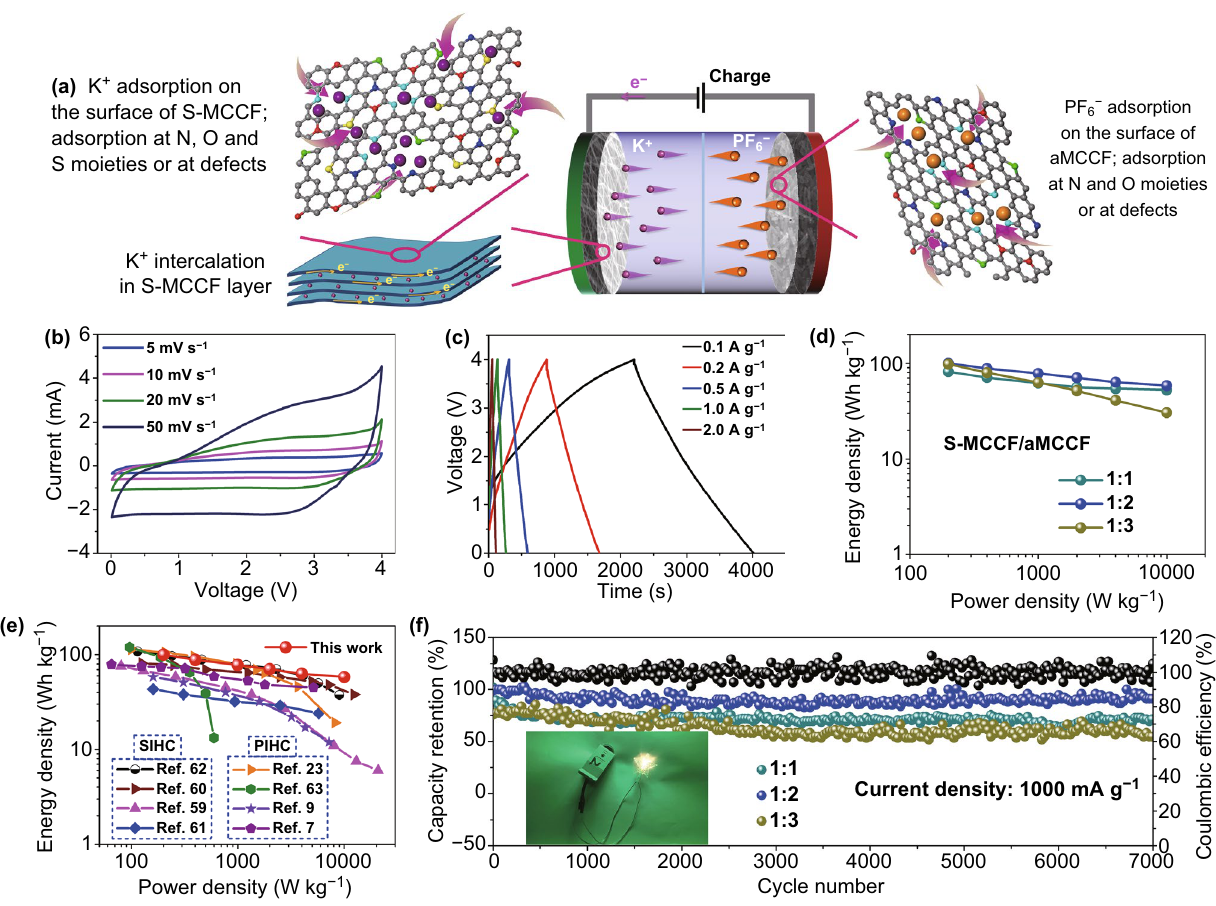
Fig. 5 a Schematic illustration of the charge process for the S-MCCF//aMCCF PIHC. Performance of the PIHC ( m anode : m cathode = 1:2): b CV curves at different scan rates. c Charge/discharge curves at different current densities. d Ragone plots of the energy density versus power den- sity for the PIHC with three mass ratios. e Ragone plots of the optimal S-MCCF//aMCCF PIHC (mass ratio of 1:2) compared with that of the reported SIHC and PIHC. f Cycling stability of the fabricated PIHC at 1000 mA g −1 , with the inset showing a photo image of a LED panel pow- ered by the